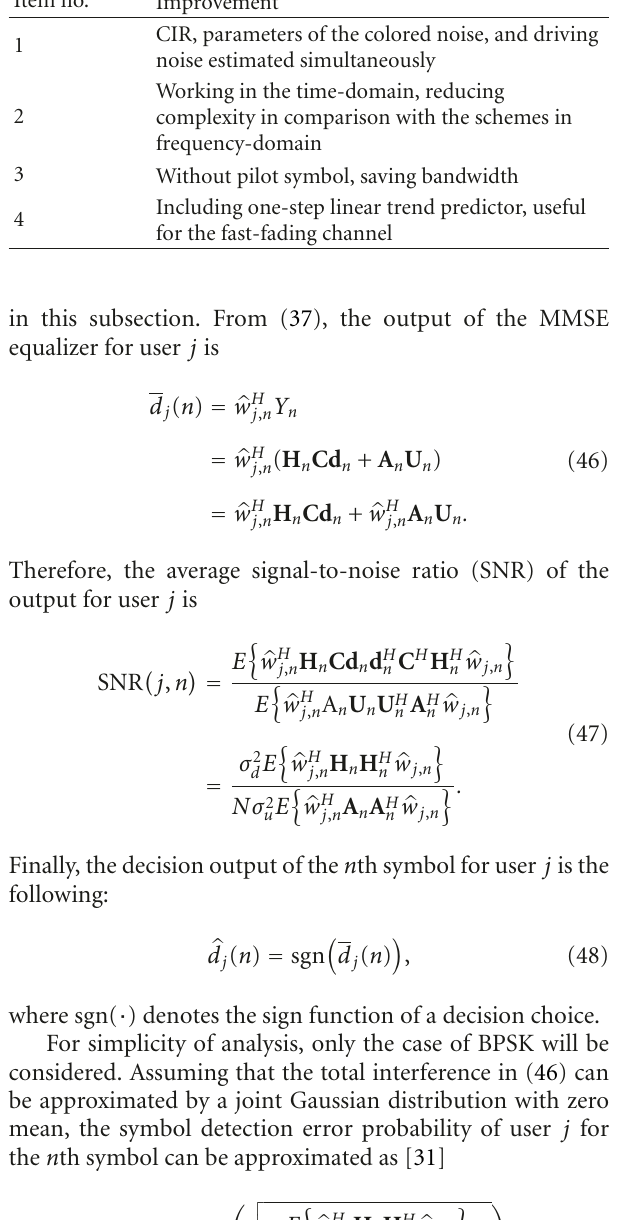
Table 1: Summarization of the merits of the proposed scheme. Item no. Improvement CIR, parameters of the colored noise, and driving 1 noise estimated simultaneously Working in the time-domain, reducing 2 complexity in comparison with the schemes in frequency-domain 3 Without pilot symbol, saving bandwidth Including one-step linear trend predictor, useful 4 for the fast-fading